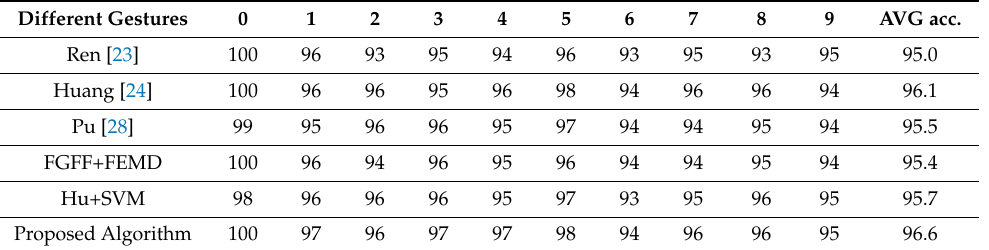
Figure 11. Digital gesture recognition confusion matrix. Table 4. Comparison of the proposed algorithm with Benchmark methods on our dataset